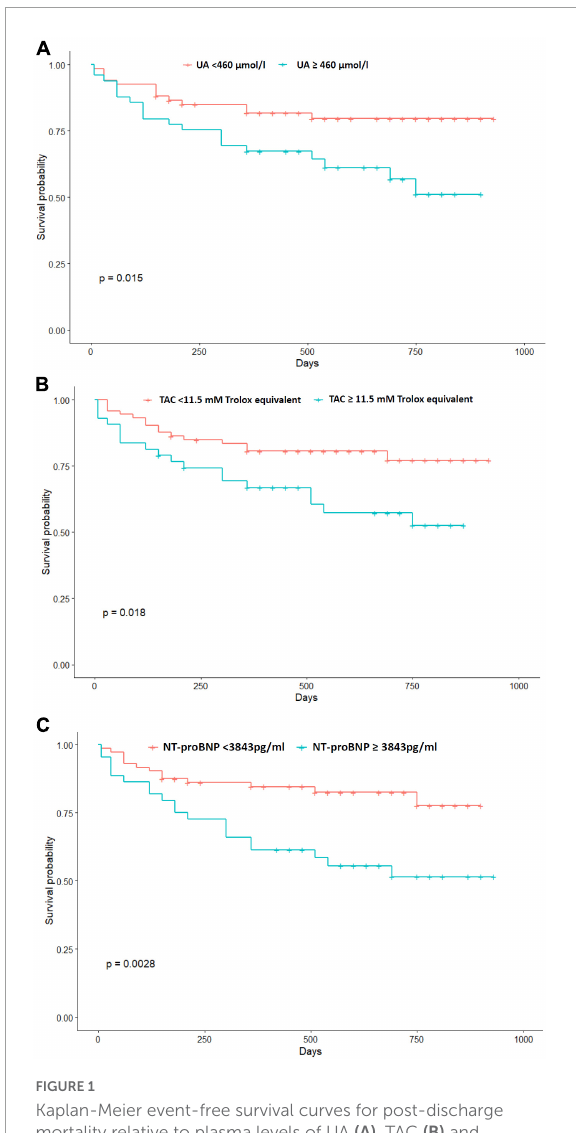
FIGURE1 Kaplan-Meier event-free survival curves for post-discharge mortality relative to plasma levels of UA (A) , TAC (B) and NT-proBNP (C) above or below cut-off values.